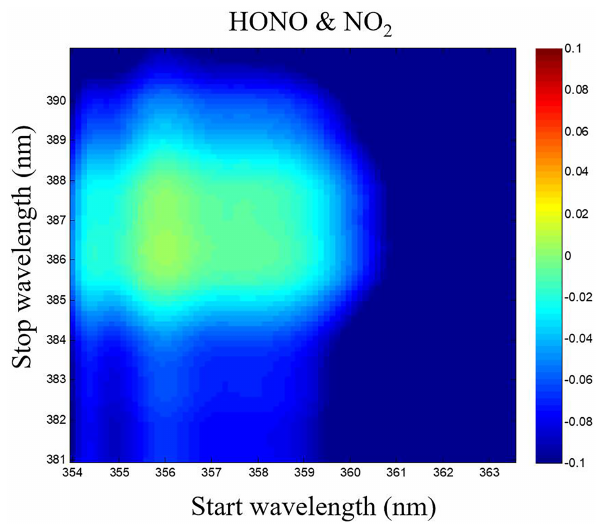
Figure 7. Correlations matrix of HONO and NO 2 for different wavelength intervals in the 354–391nm wavelength range.